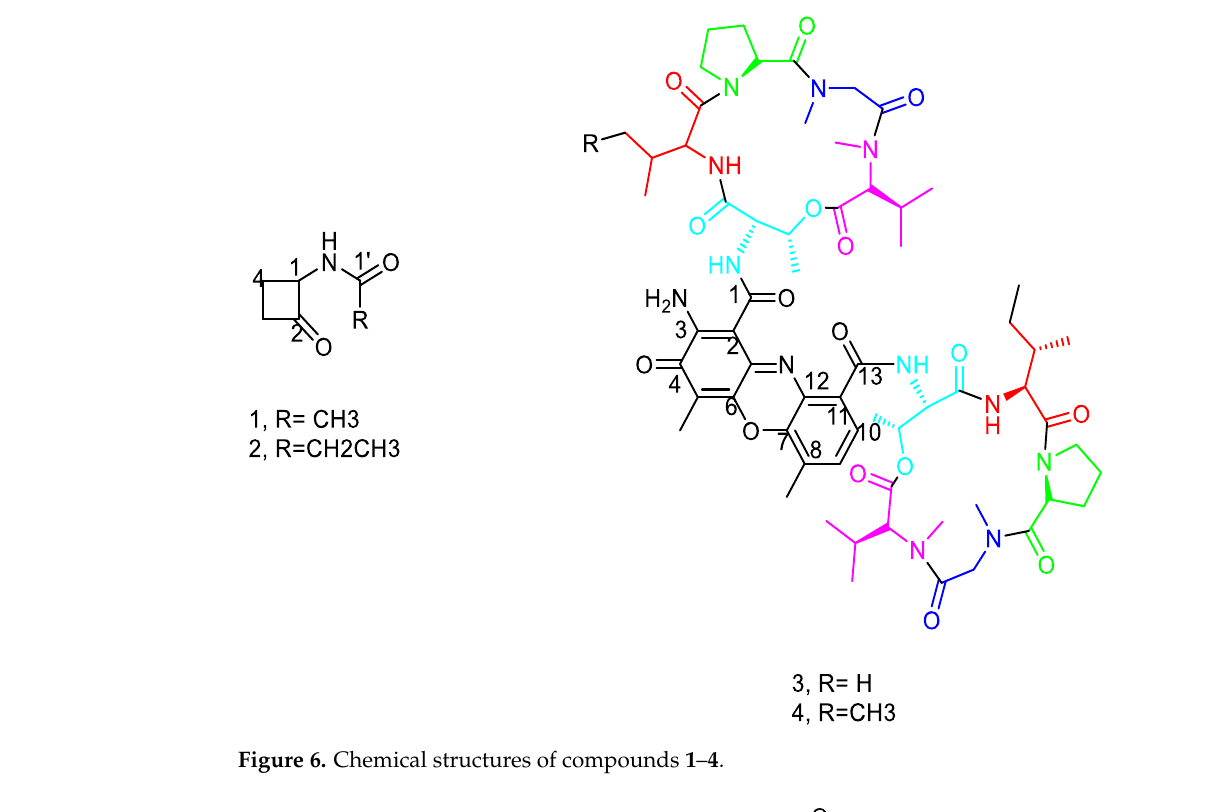
Figure 6. Chemical structures of compounds 1 – 4 .